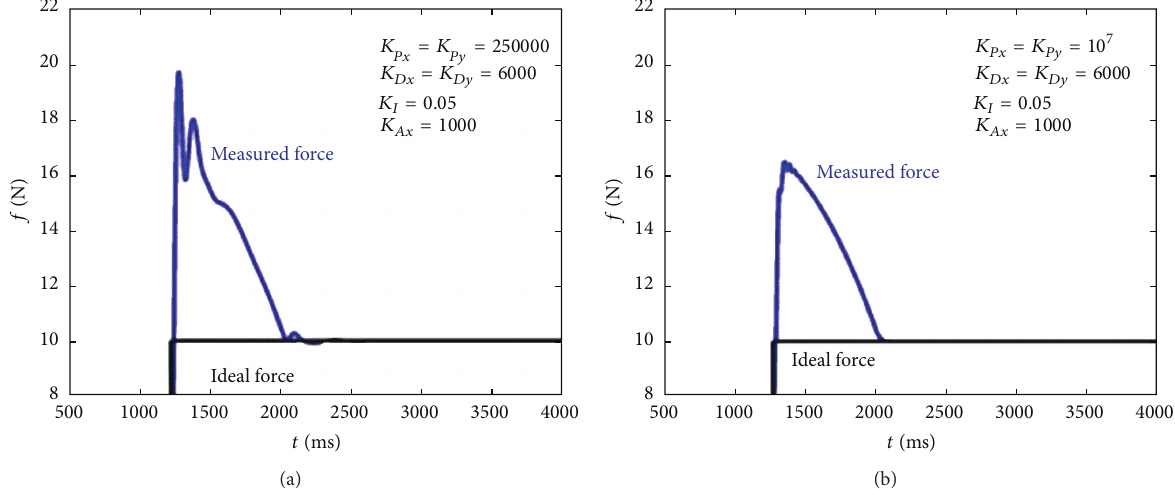
Figure 25: End-Effector force value (N) varying the 𝐾 𝑃 gain in the P system: (a) 𝐾 𝑃 = 250000 ; (b) 𝐾 𝑃 = 10 7